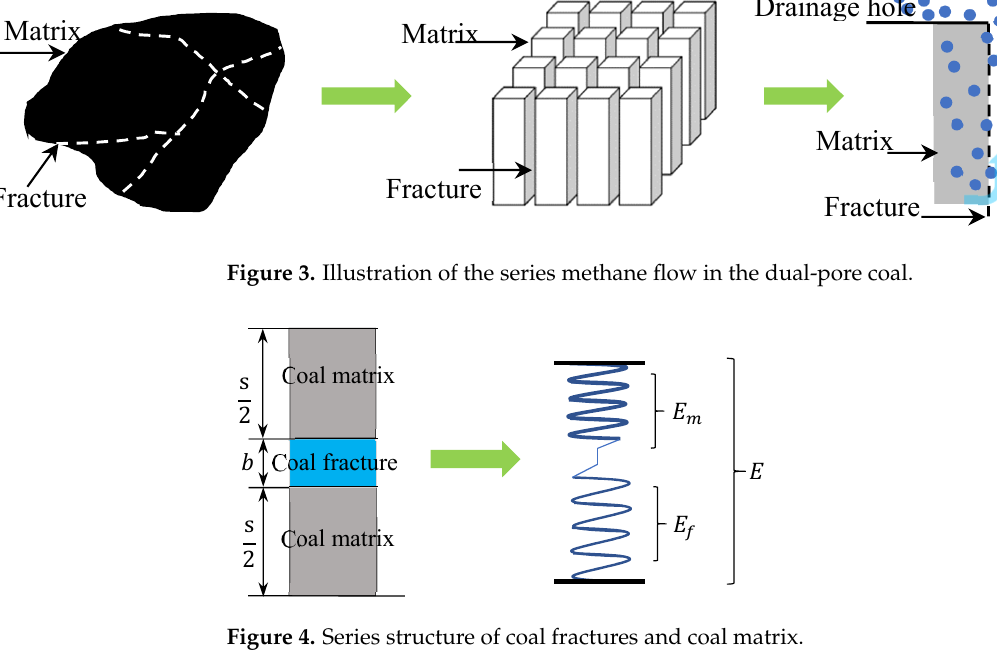
Figure 4. Series structure of coal fractures and coal matrix.